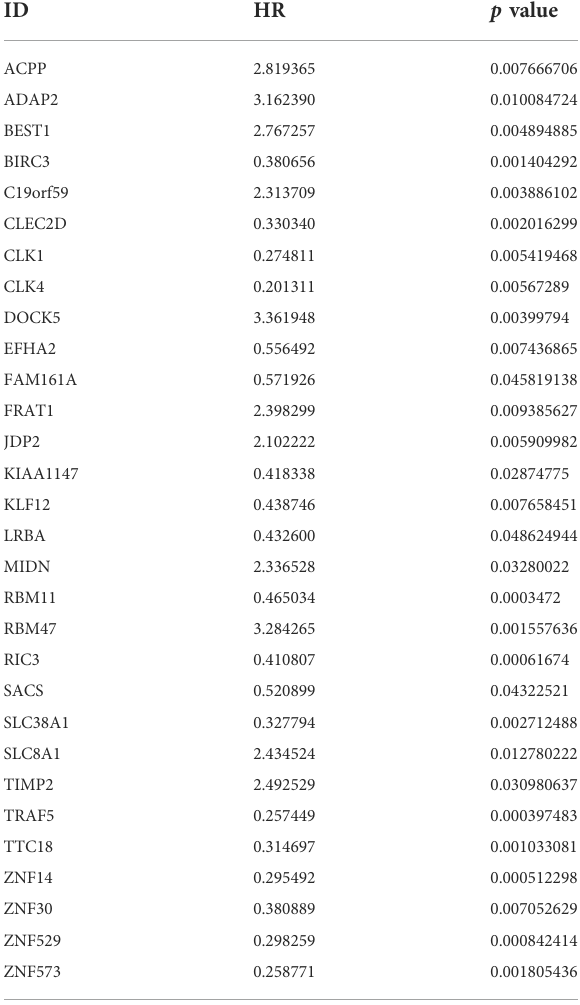
TABLE 1 The univariate Cox regression analysis demonstrating 30 genes associated with IPF